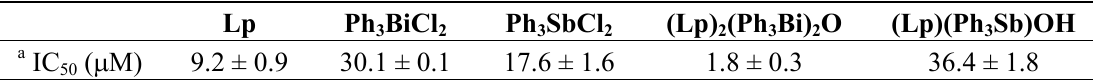
Table 3. Growth inhibition of K562 cells by lapachol, Ph their